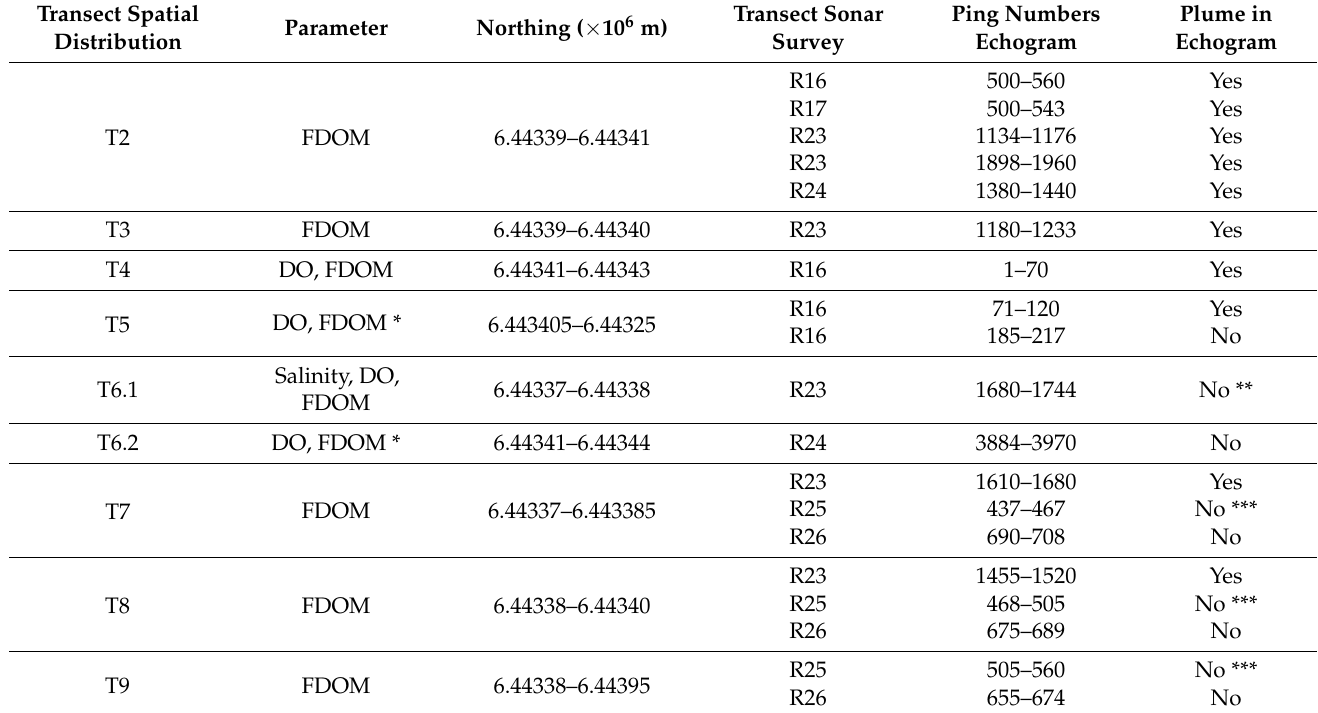
Table 6. Summary of potential SGD areas identified from spatial distribution plots, and the number of sonar transects crossing these areas with corresponding ping